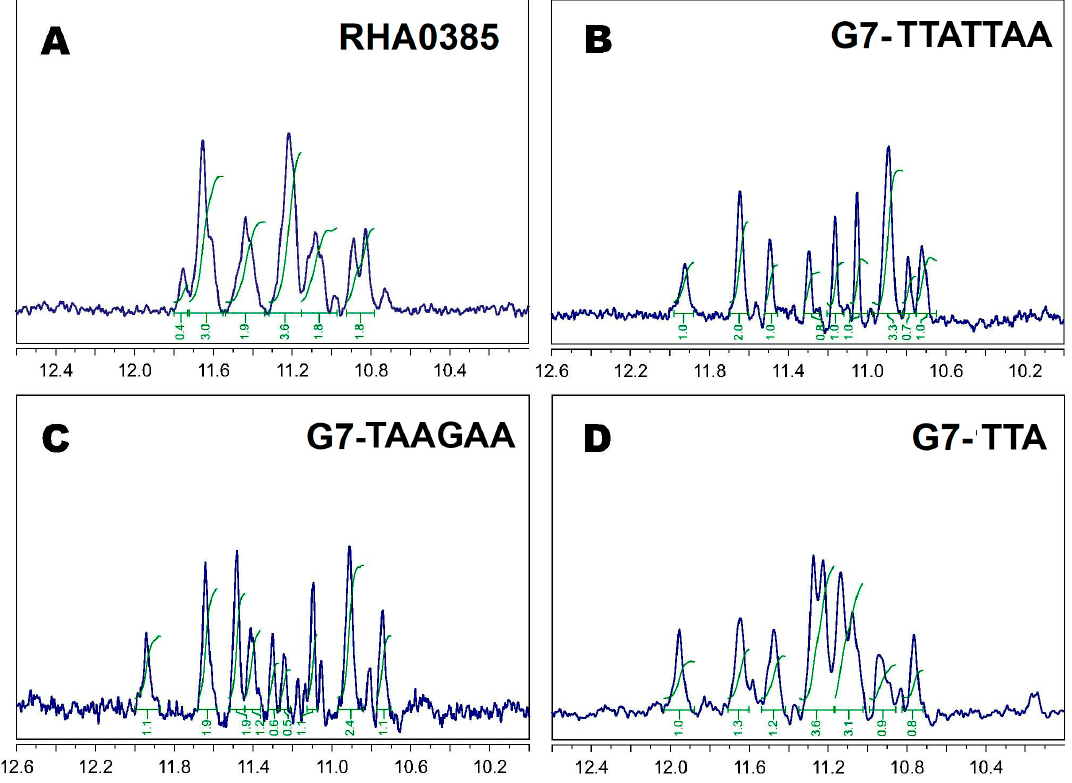
Figure 4. 1 H ‘oligomers filtered’ NMR spectra with ‘ WATERGATE W5 ’ water suppression of ( A ) RHA0285, ( B ) G7-TTATTAA, ( C ) G7-TAAGAA, ( D ) G7-TTA at 5 °C in PBSK had the peaks of 12 G-quadruplex imino protons within the range of 10.5–12 ppm; all peaks are numbered in the first approximation for major monomer patterns; all spectra are mathematically processed to suppress a wide oligomeric humps using “multipoint baseline correction” algorithm.